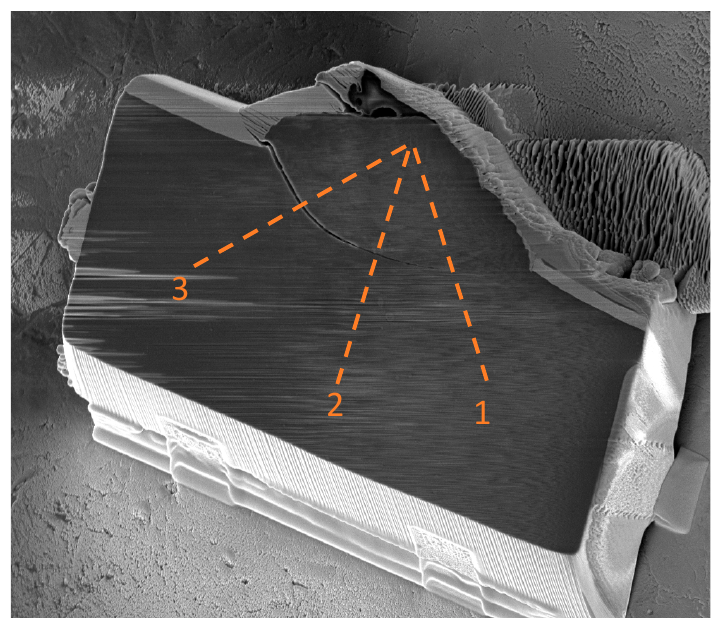
Figure 52. Once the laser induced projective impact testing (LIPIT)-deposited sample’s cross-section was obtained, prospective nanoindentation array of 1 column and 5 rows were conceptualized, as shown herein.